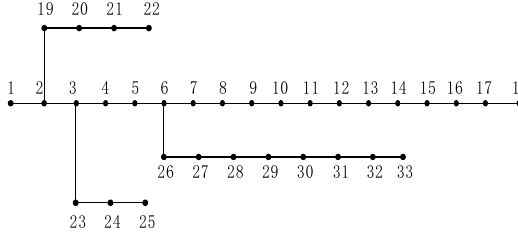
Figure 7. IEEE 33 nodes power distribution system.